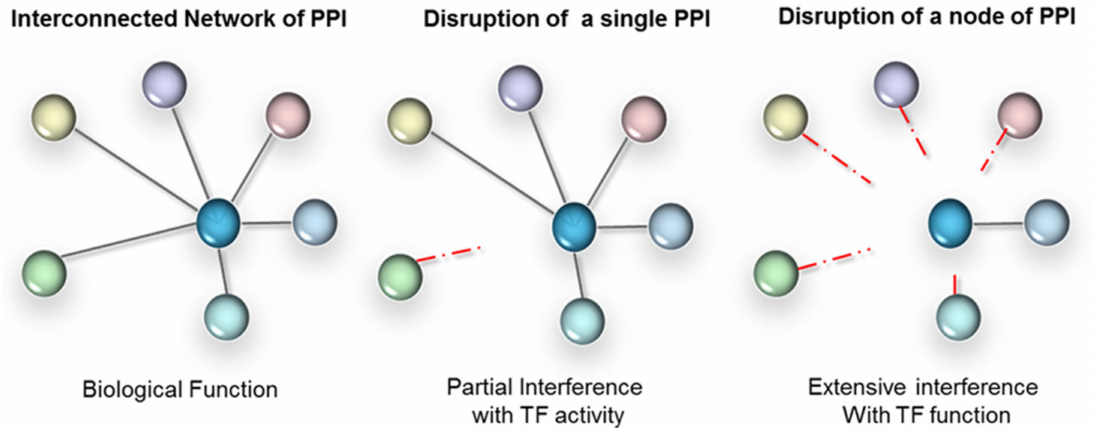
Figure 2. PPI interference strategy for TFs. Left panel: TFs form extensive networks of PPI, have many gene targets and regulate complex biological processes. Parallel signalling often overlaps functionally. Middle panel: interference with a single PPI (mutant or drug based) will only a ff ect those target genes and functions that rely on those interactions. Right panel: a strategy that relies on broad-scale interference with a node of interactions is likely to more completely ‘knock-out’ the TF